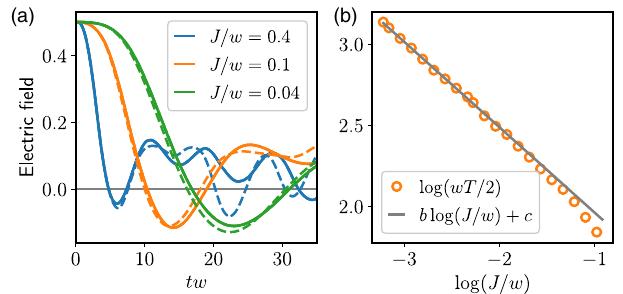
FIG. 4. Oscillation of the electric field in the Schwinger model with θ ¼ π . (a) Time evolution of the average electric field. The initial state is the bare vacuum with E j;j ¼ 1 = 2 and the chain þ 1 has periodic boundary conditions. The solid and dashed lines correspond to L ¼ 14 and L ¼ 12 , respectively. Exact simula- tions are performed via truncation of the local Hilbert space to dimension 16, i.e., j E j;j j < 15 = 2 , and the constrained Hamil- þ 1 tonian for the electric field is obtained by eliminating matter degrees of freedom. (b) Period T of the oscillations as a function of J and w . Data points correspond to values of the logarithm of the half period T obtained for L ¼ 14 . The solid line is the function b log ð J=w Þ þ c , where b ¼ − 0 . 526 and c ¼ 4 . 2 are obtained through a fit in the region J=w < 0 . 1